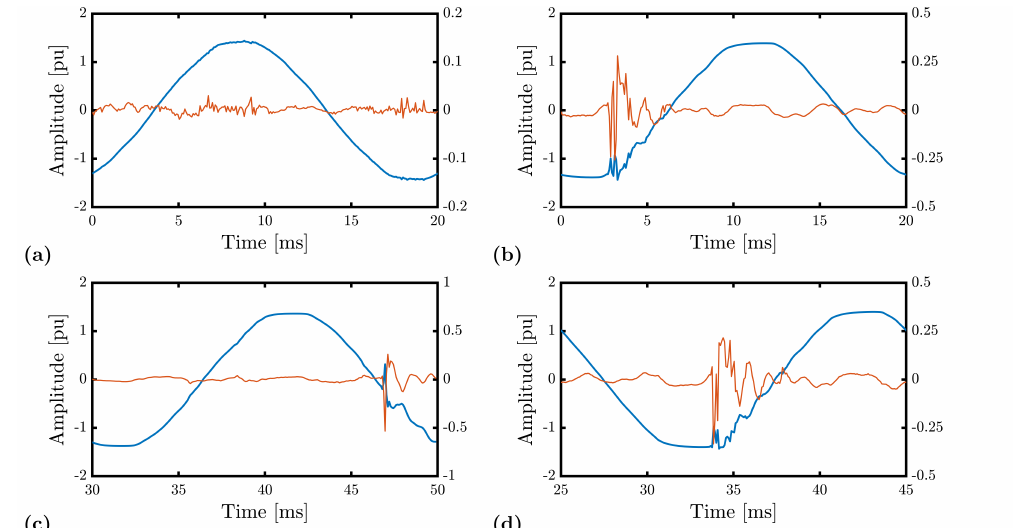
Figure 8. Examples of the operation of the 1D CNN: ( b – d ) depict transients while ( a ) is a transient-free segment. The blue lines depict the input time series (left vertical axis) while the red lines represent the difference between the input and output time series (right vertical